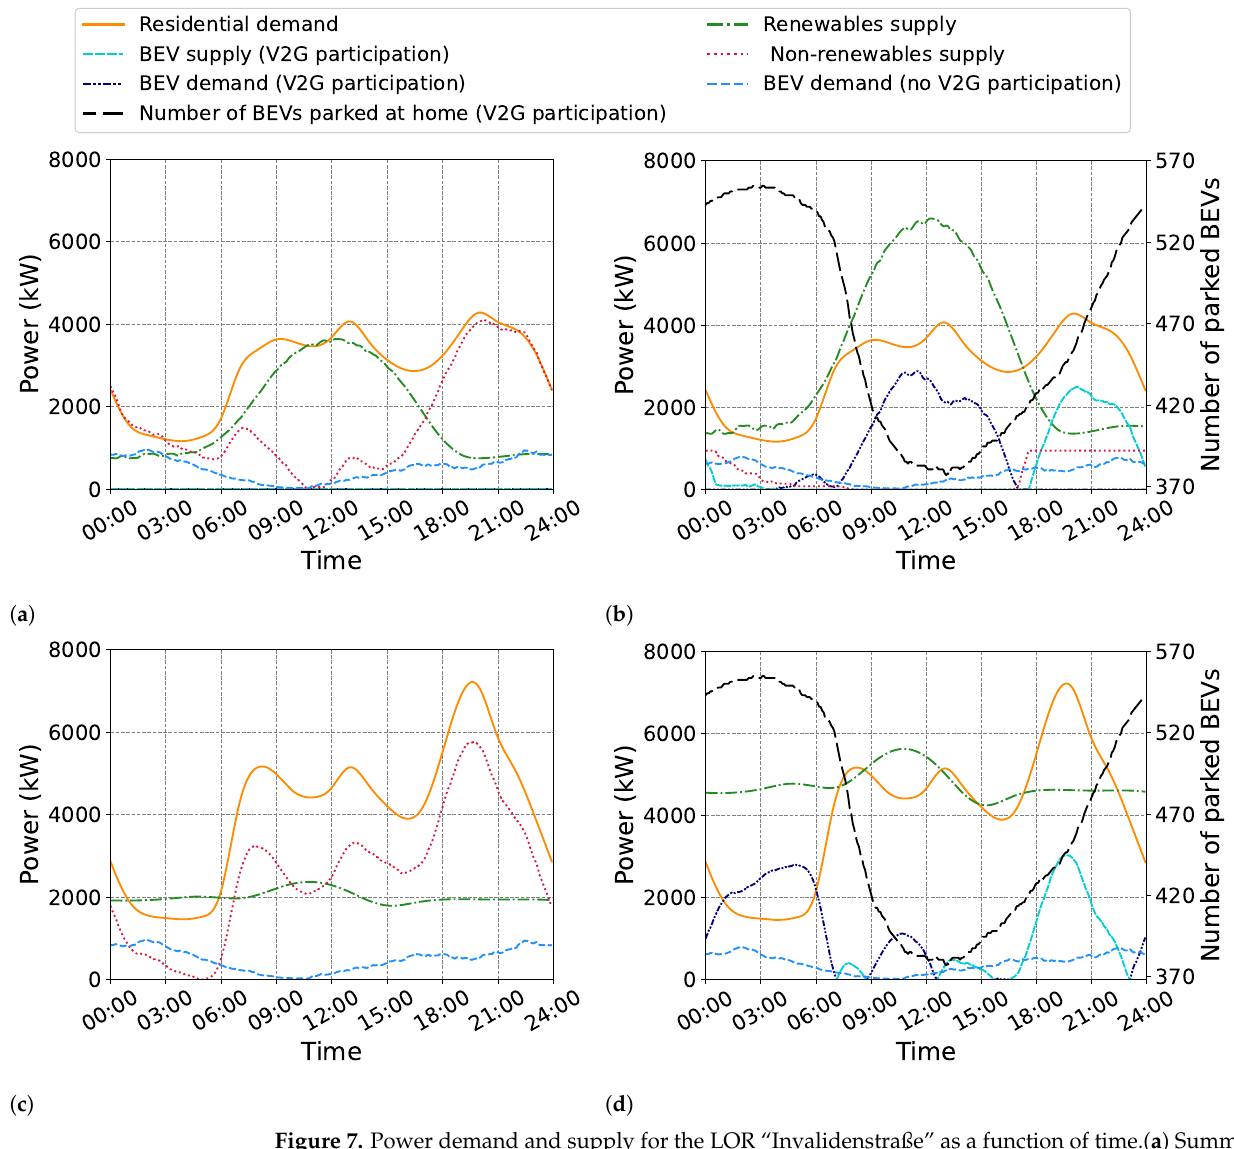
Figure 7. Power demand and supply for the LOR “Invalidenstraße” as a function of time.( a ) Summer case. 0% vehicle participation in V2G. ( b ) Summer case. 20% vehicle participation in V2G. ( c ) Winter case. 0% vehicle participation in V2G. ( d ) Winter case. 20% vehicle participation in